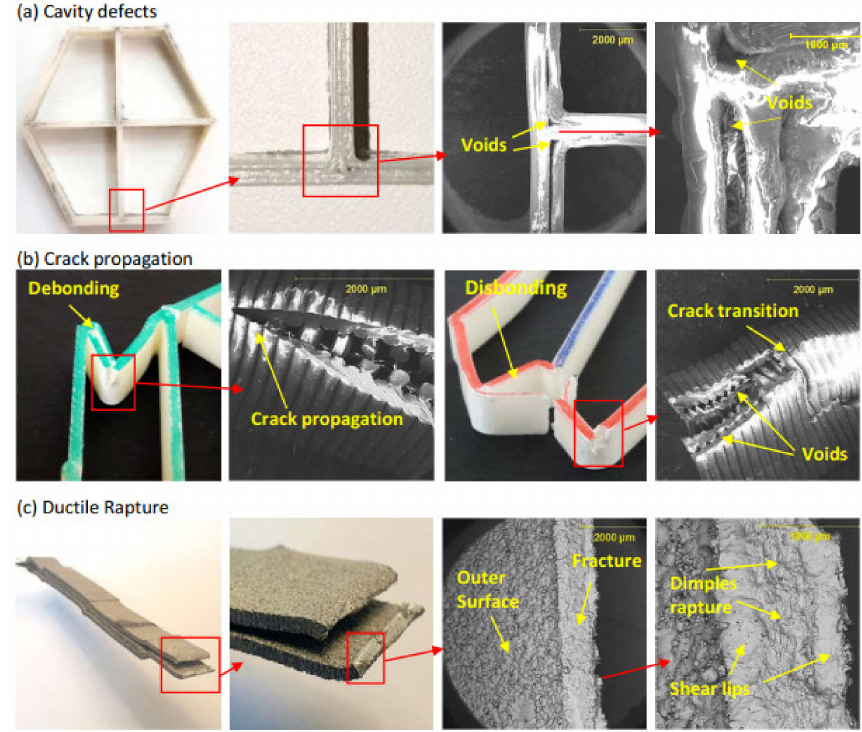
Figure 6. Scanning electron microscopy photographs highlighting ( a ) defects from FDM printing at the joints, ( b ) crack propagation perpendicular to printing paths and crack transition in-between those paths, and ( c ) material ductile rupture from excessive deflection in the DMLS